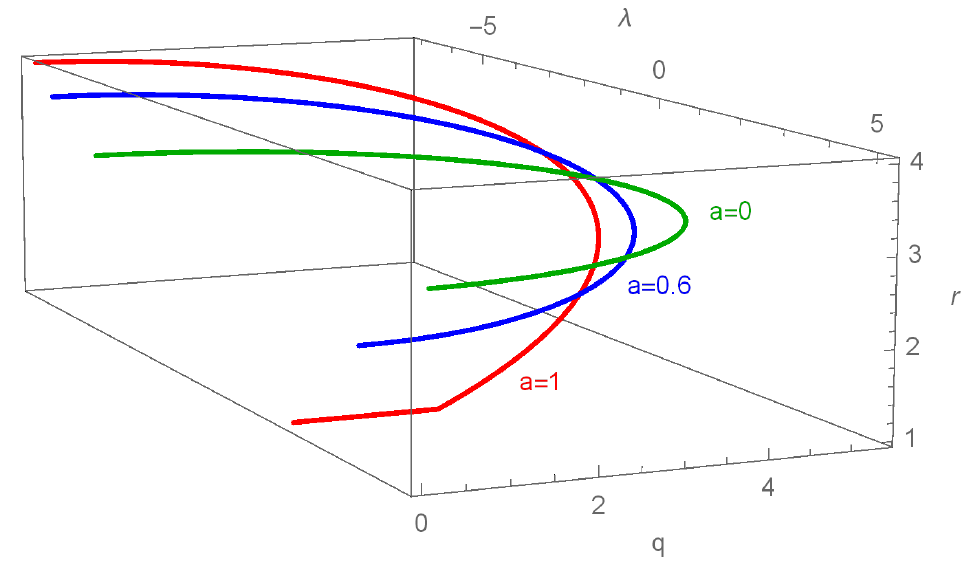
Figure 4. The radii of photon spheres depend on one of the photon orbit parameters, λ or q . At a = 1 the photon spheres (red curve) are placed at radii r ph = 1 + The corresponding photon spheres exist at the radial interval 1 ≤ r ph ≤ 4. At a = 0 the photon sphere is reduced to the photon circle with radius (green semicircle) with λ 2 + q 2 = 27. A blue curve corresponds to the radii of photon spheres at a =